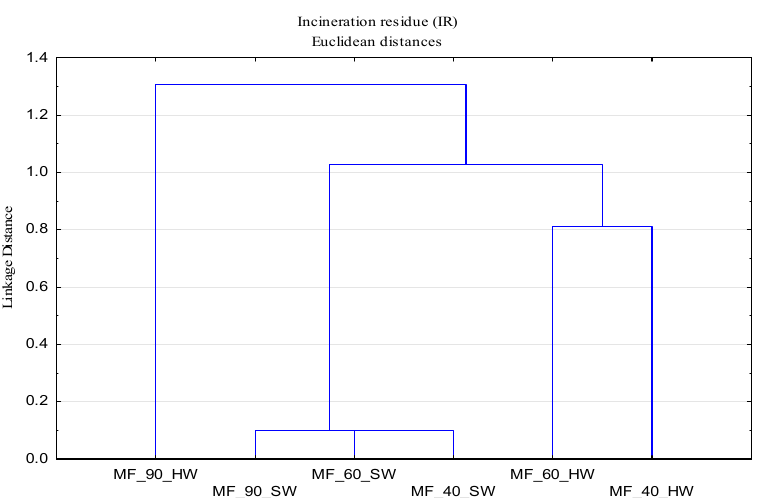
Figure 1. Dendrogram of the incineration residue data (IR) for carboxymethyl cellulose (CMC), carboxymethyl starch (CMS) and CMC + CMS as objects, and different temperatures, soft (SW) and hard water (HW) as variables.